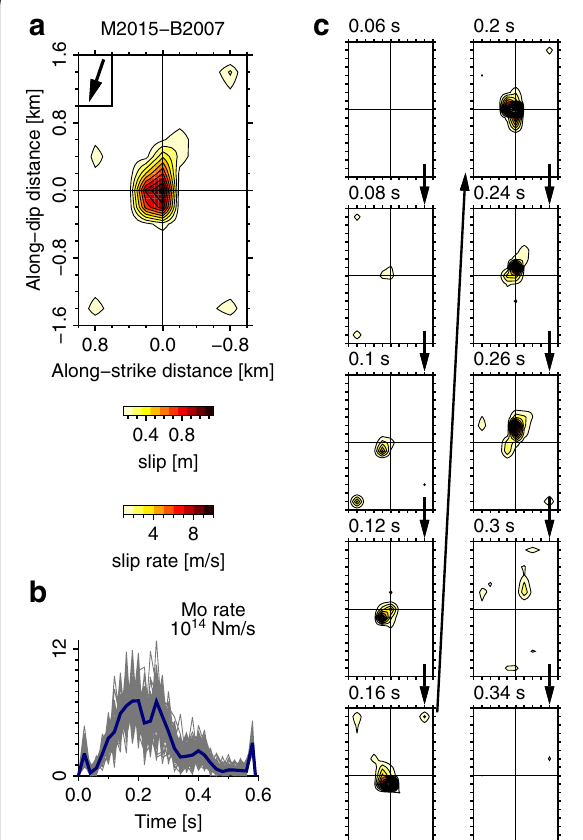
Fig. 7 M2015 source process. a Total slip distribution. The down direction in the figure indicates the down-dip direction, and the black arrow at upper left shows the slip direction from the F-net data.The origin indicates the B2007 source location (eGf event). b Moment rate function. The gray lines represent each trial, and the blue line is the average. c Slip rate history. The modeled region in ( c ) is the same as in ( a